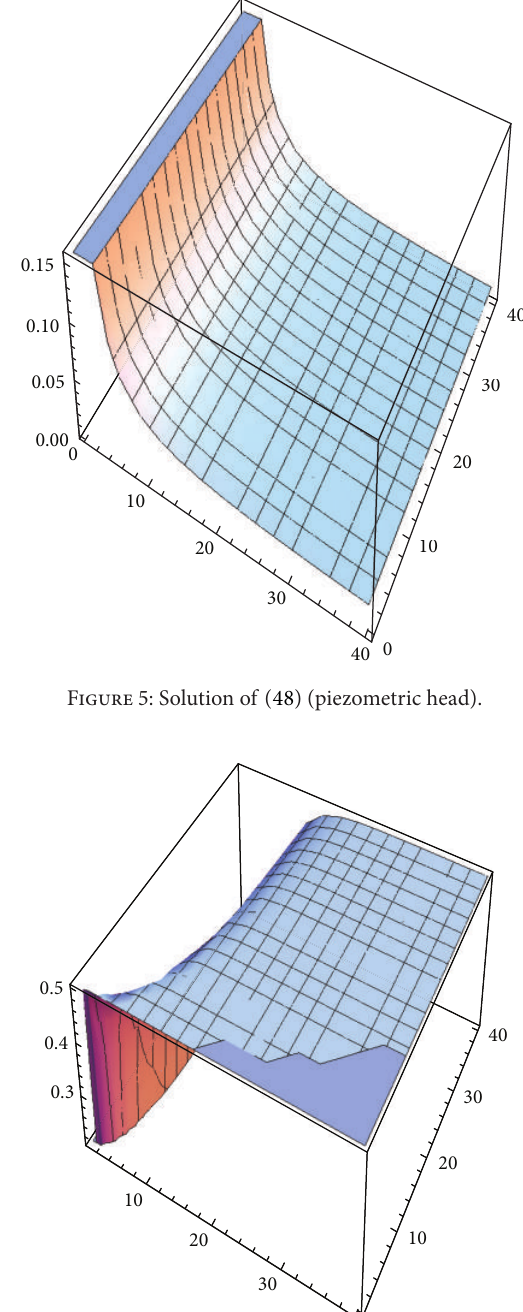
Figure 4: Barker’s solution.